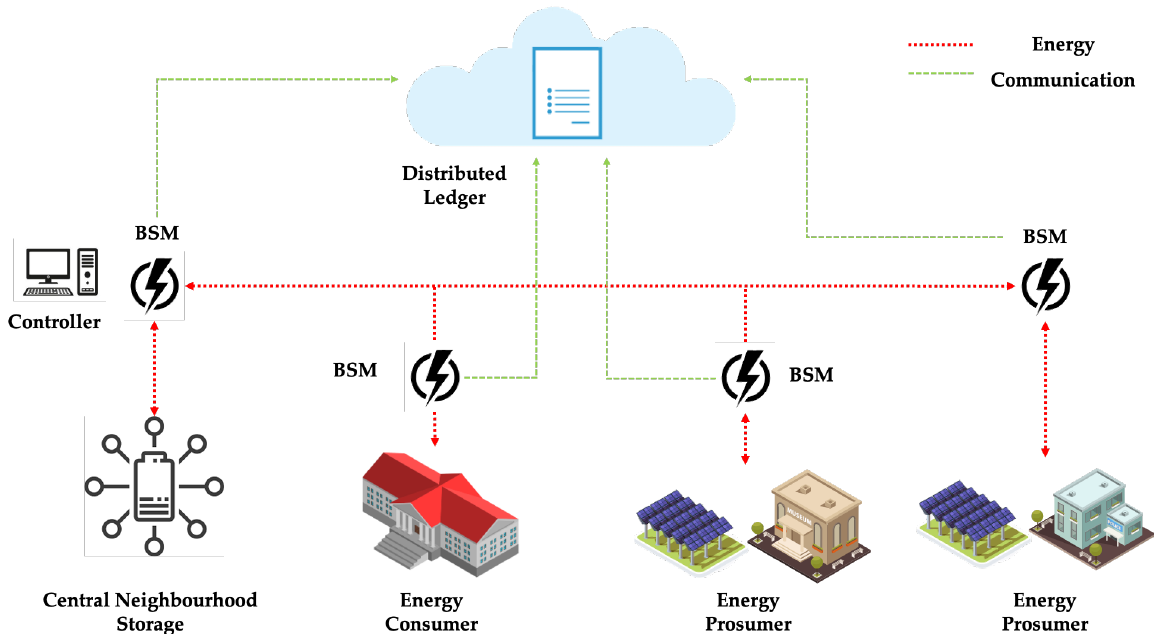
Figure 1. Architecture of the local energy community (LEC)